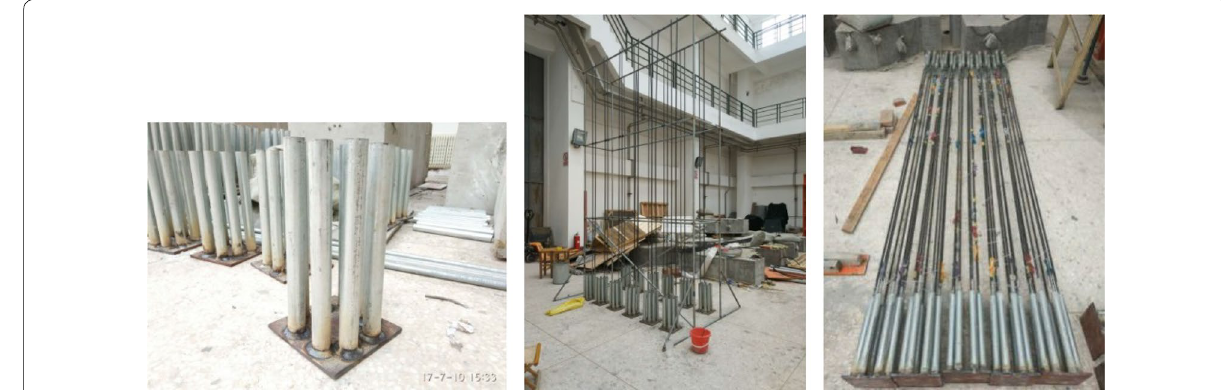
Fig. 2 Anchorage setup for CFRP bar.